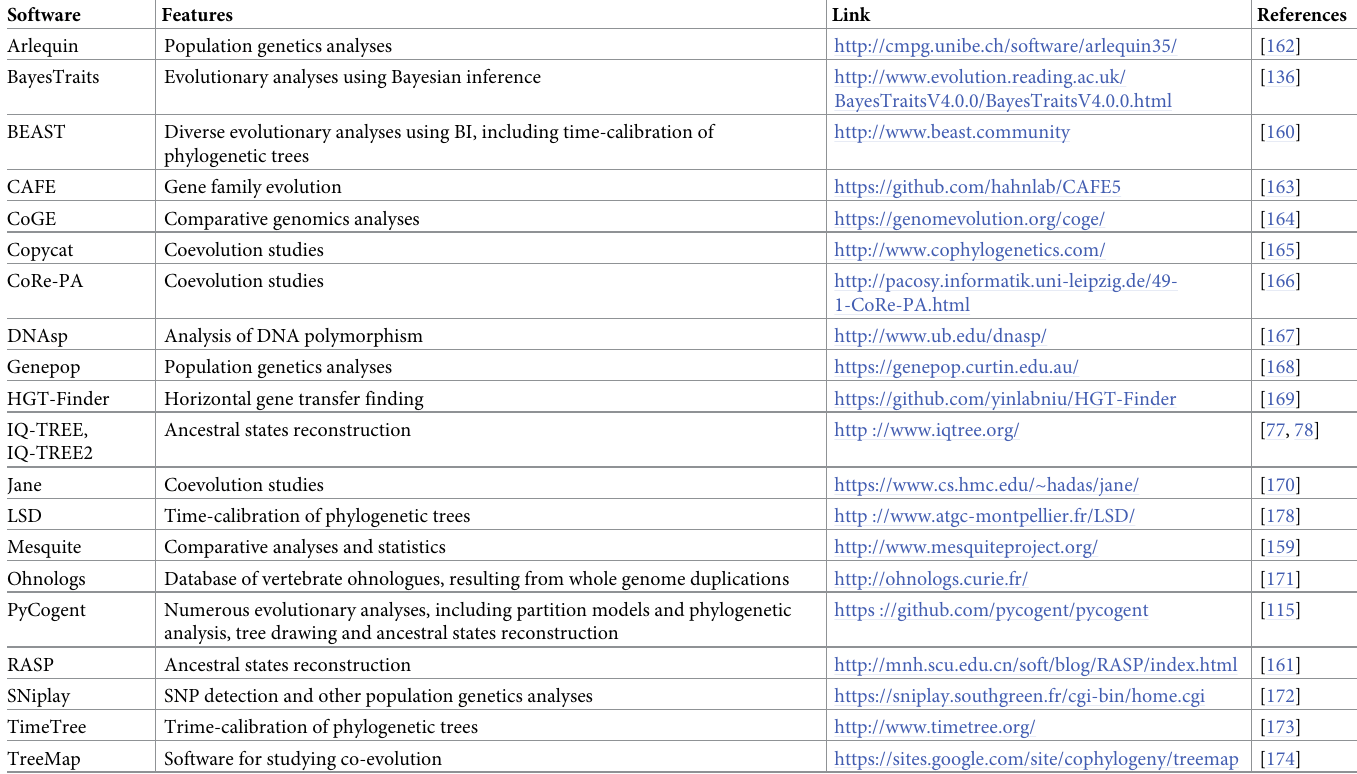
Table 10. List of programs and databases for diverse evolutionary analyses in complement to phylogenetic analysis.